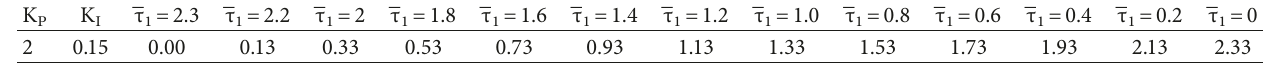
− 1, the highest acceptable delay bound τ ̅ 1